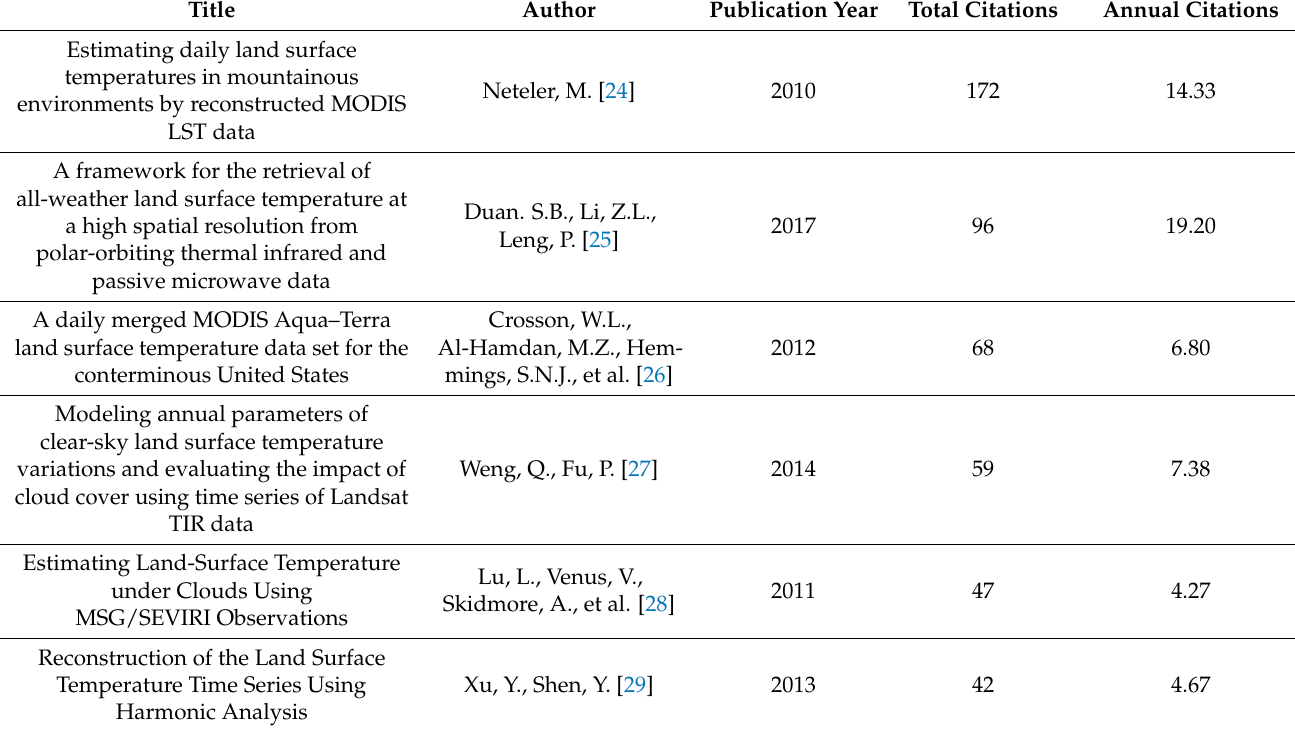
Table 2. Top 10 papers with the highest number of